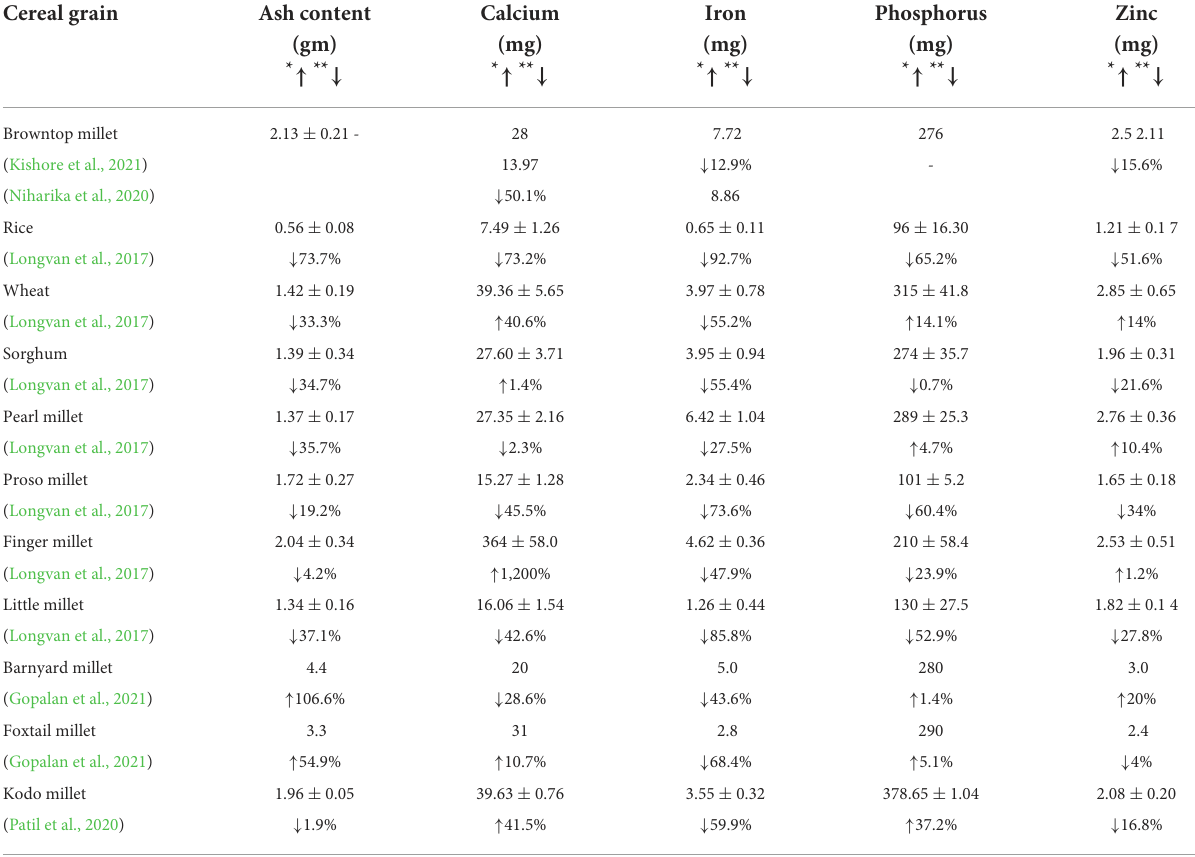
TABLE 4 Comparison of micro-nutrients content of millets and staple cereals with the browntop millet (in percent). Cereal